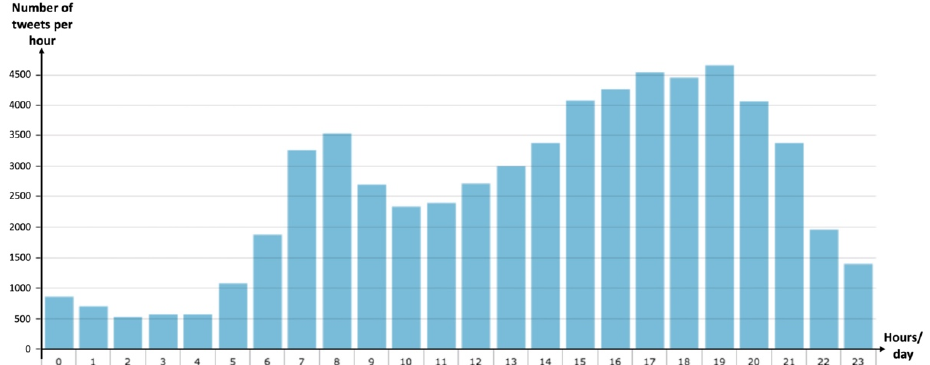
Figure 5. Relation of traffic ‐ related events with Twitter.